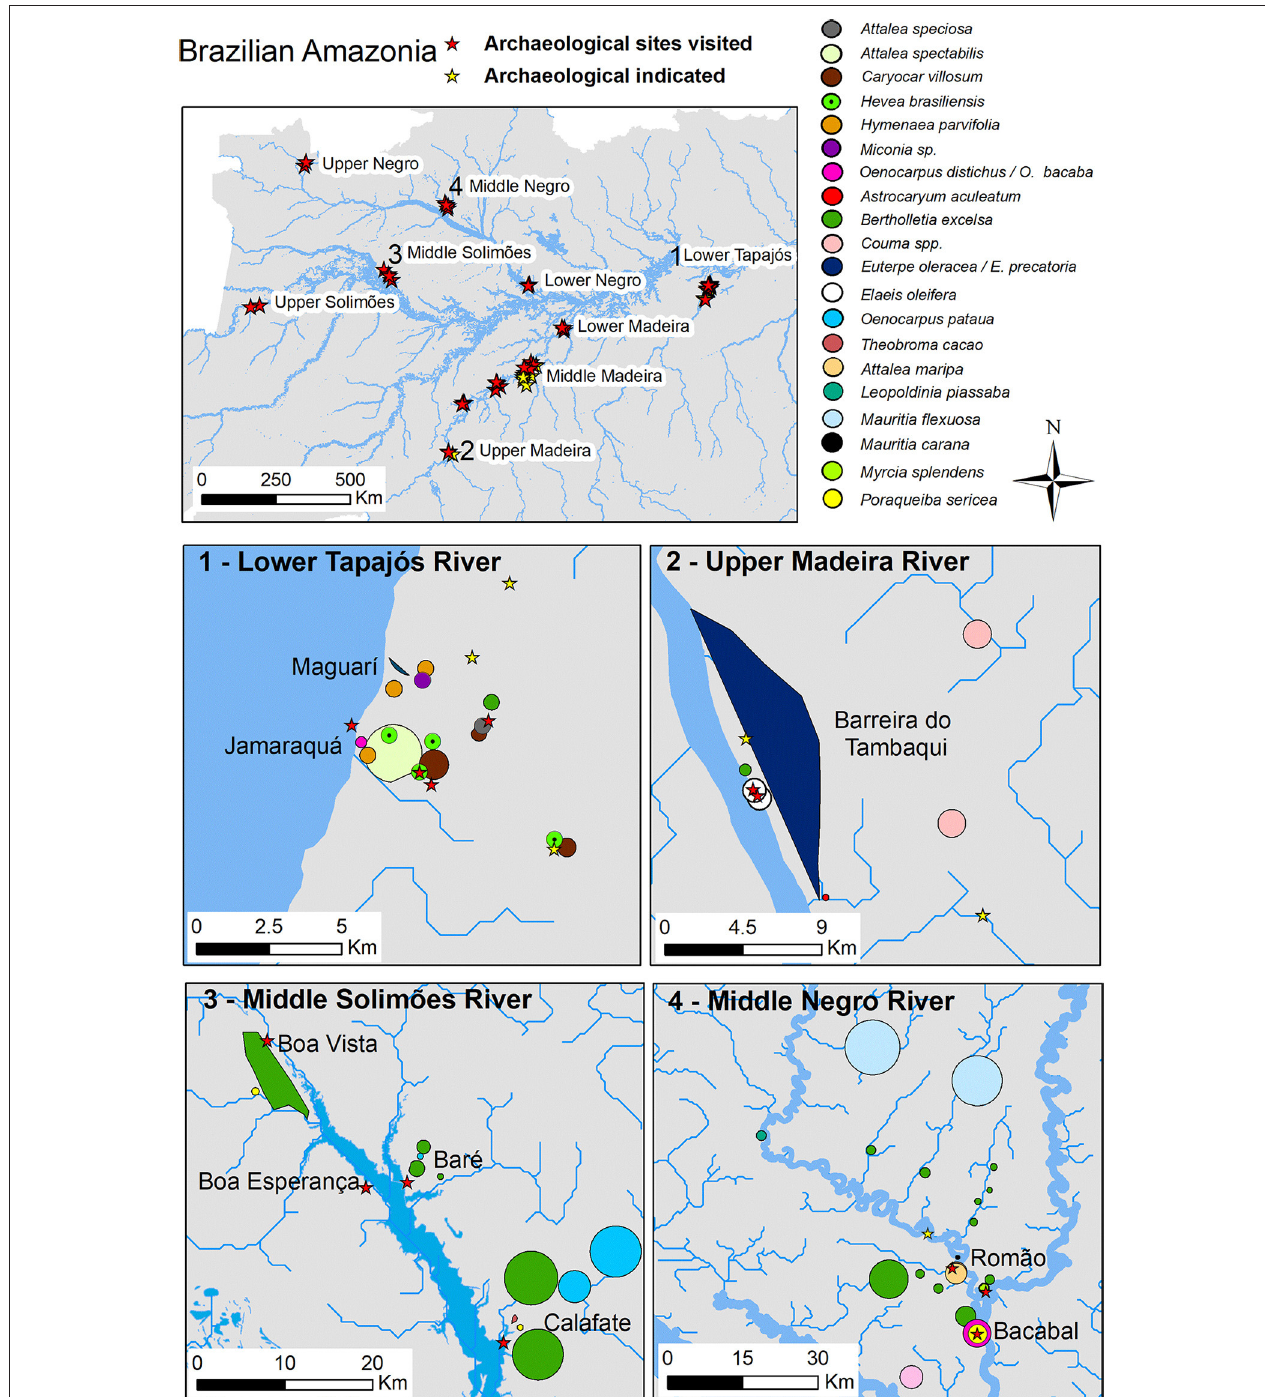
FIGURE 3 | Maps of examples of useful forest patches around archaeological sites in four sub-basins of Brazilian Amazonia. Different sizes and shapes of forest patches presented in the figures are based on local knowledge descriptions and local drawings. See Supplementary Table 1 for more information about the forest patches presented in this figure. Archaeological sites are ancient sedentary settlements with anthropogenic soils (TPI) and have been re-occupied by contemporary peoples.